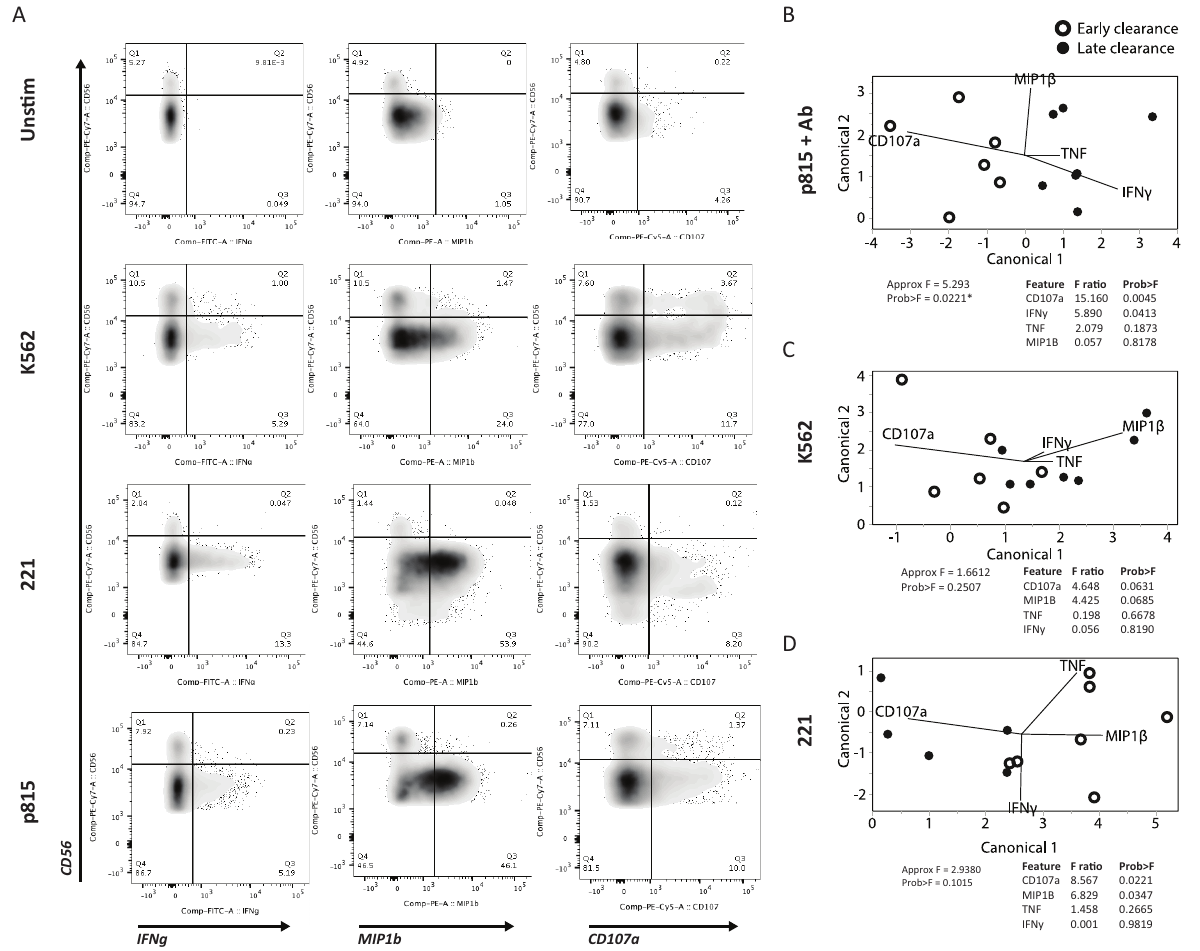
Figure 3. NK-cell degranulation as a correlate of HBsAg clearance. NK-cell activity was assessed follow- ing NK-cell stimulation with antibody-opsonized target cells to drive antibody dependent cellular cytotox- icity; ADCC (antibody+p815 cells), NKG2D activation (K562), or NCR activation (221). (A) Flow plots show the level of degranulation by CD107a, and cytokine (IFNγ) and chemokine (MIP1β) production on NK-cell populations in 3 stimulated as well as unstimulated conditions. (B-D) A multivariate PLSDA was used to differentiate the profiles of the early and late clearers activated via (B) ADCC, (C) NKG2D, and (D) NCR, distributed in the first 2-dimensional principle components, based on 4 measured features (CD107a, IFNγ, TNF, and MIP1β). The contribution of the features to group separation were visualized by the lines in the plots, and its F ratio and P -values were listed on the right side based on Approximate F